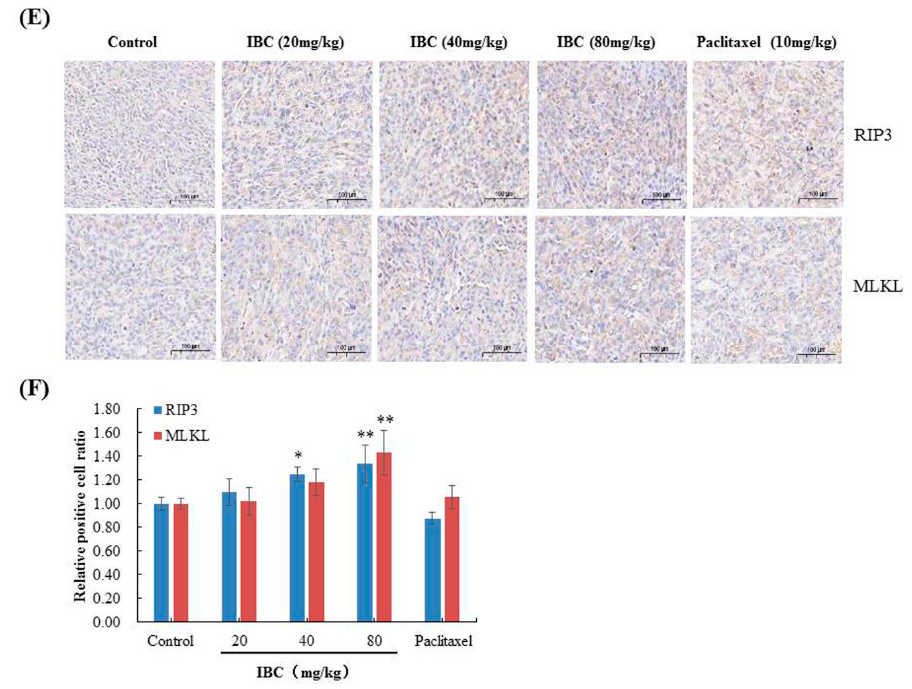
Figure 10. Anti-tumor efficacy of IBC in MDA-MB-231 cell xenografts in nude mice ( n = 3). ( A ) Representative tumors from each treatment group. ( B ) Tumor volume of each treatment group. ( C ) Body weight changes of nude mice. ( D ) H and E-stained sections of the tumor, liver, kidney, and lung from the mice after treatment with increasing doses of IBC (20, 40, and 80 mg/kg). ( E ) Immunohistochemistry of RIP3 and MLKL. ( F ) Quantification of the immunohistochemistry. * p < 0.05, ** p < 0.01, and *** p < 0.001 compared with the control.